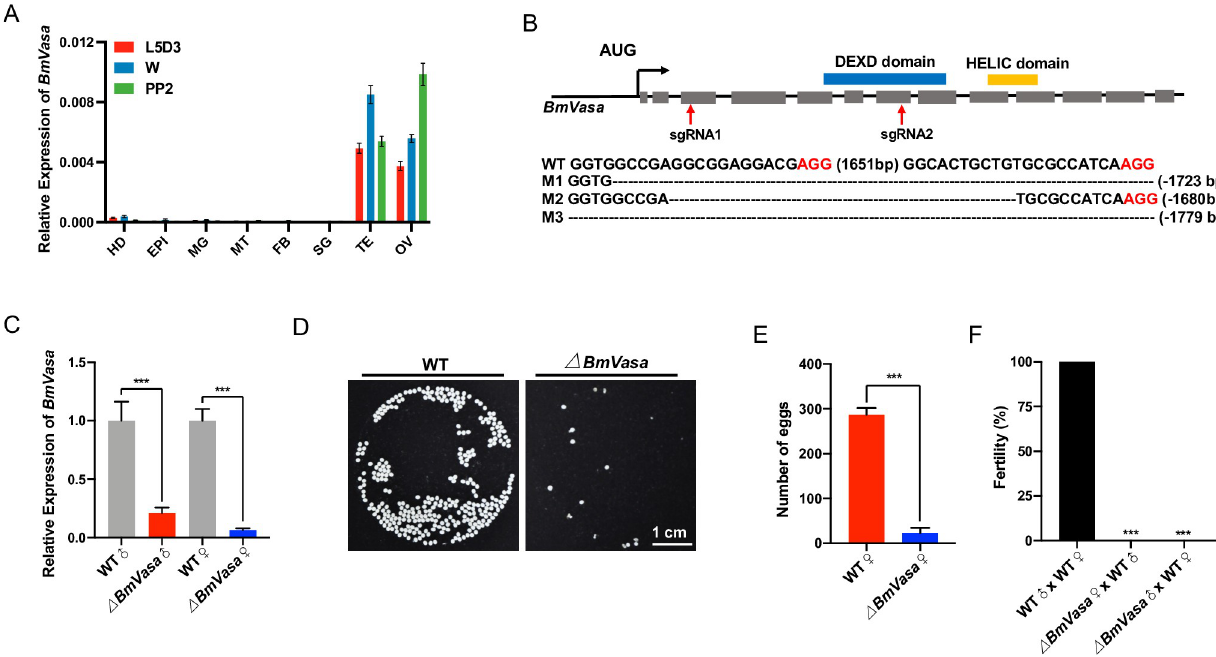
Fig 4. Loss-of-function of BmVasa causes both male and female sterility in B . mori . (A) qRT-PCR analysis of BmVasa mRNA levels in eight tissues at three different stages. HD, head; EPI, epidermis; MG, midgut; MT, malpighian tubule; FB, fat body; SG, silk gland; TE, testis; OV, ovary; L5D3, the third day of the fifth larval stage; W, wandering stage; PP2, the second day of the prepupal stage. BmRp49 was used as an internal reference. Data are means ± SEM. (B) Upper: Schematic of BmVasa gene structure. Gray-filed boxes represent exons, and lines represent introns. DEXD and HELIC domains predicted by SMART are highlighted with blue and yellow boxes above the gene schematic. Red arrows indicate the target sites of sgRNA1 and sgRNA2. Lower: Sequences of BmVasa gene from WT and four mutant lines. The dashed lines indicate deleted sequences. The PAM sequence is shown in red. (C) qRT-PCR analysis of BmVasa mRNA in testis and ovary of WT and BmVasa mutant wandering stage individuals. Error bars are means ± SEM (n = 3, P < 0.001, t-test). (D) Images of eggs laid by WT and BmVasa mutants. The eggs laid by BmVasa mutant females did not develop. (E) The number of eggs laid by WT and BmVasa females bred to WT males (n = 6, P < 0.001, t-test). (F) Fertility of males and females of the indicated genotypes (n = 15, P < 0.001, Fisher’s exact test). Δ BmVasa represents BmVasa